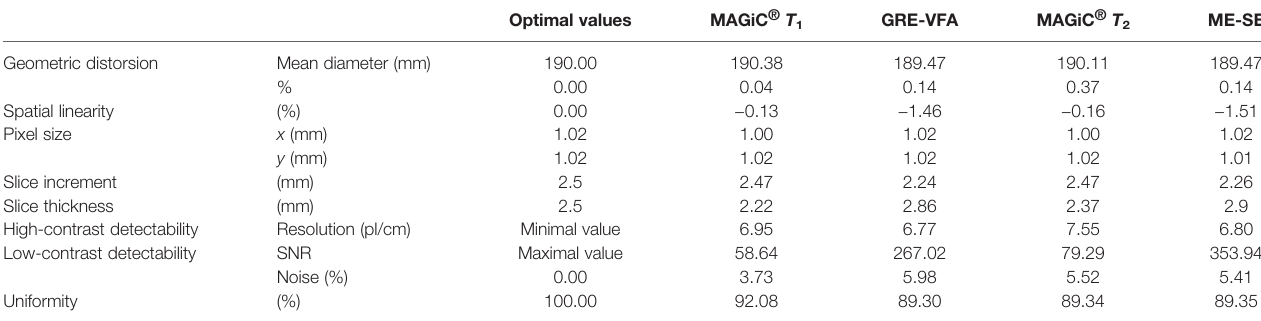
TABLE 2 | Values of the quality assurance (QA) parameters for